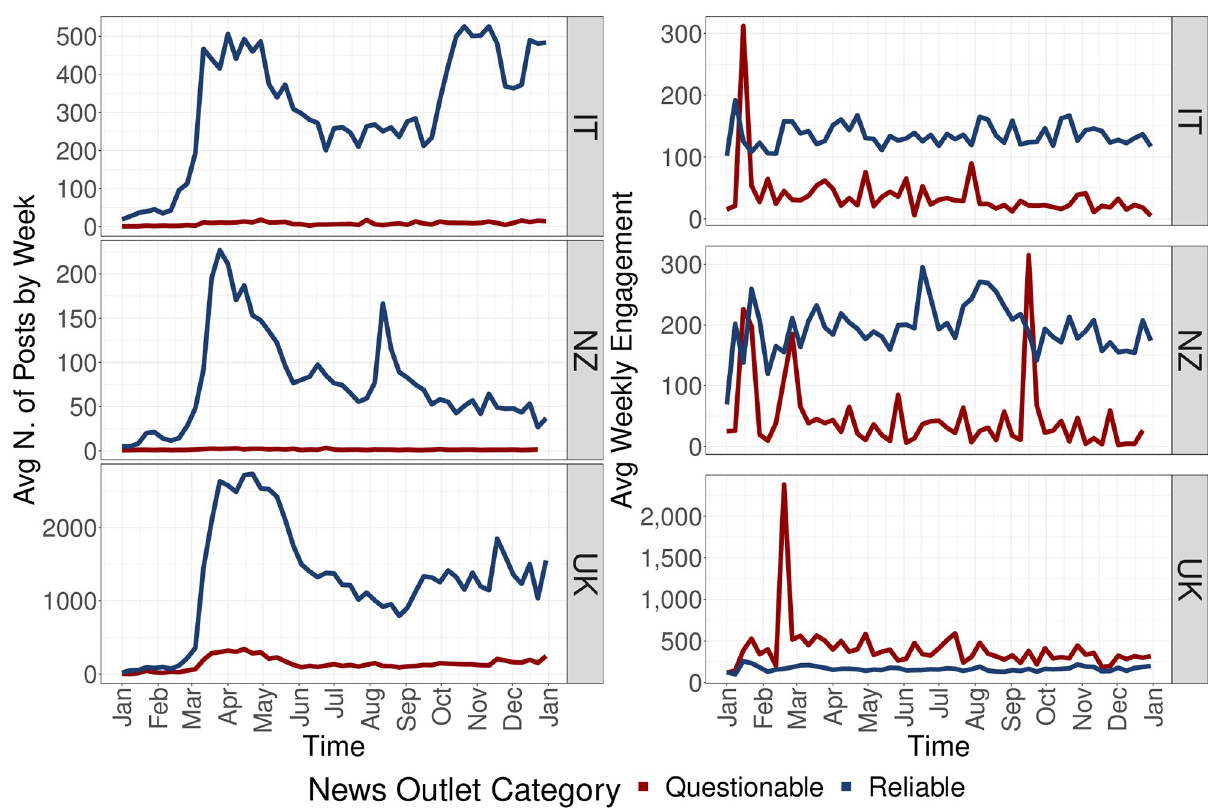
Fig 2. Left panel: Average weekly number of posts that circulated on Facebook for Italy (upper), New Zealand (middle) and the United Kingdom (bottom), with respect to the news outlet category. Right panel: Average weekly number of post interactions for Italy (upper), New Zealand (middle) and the United Kingdom (bottom), with respect to the news outlet category of the post the interactions refer to.